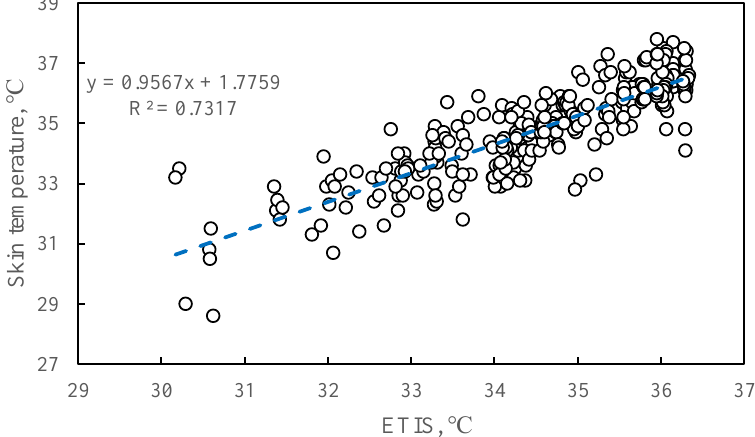
Figure 6. Regression of equivalent temperature index for sows to skin temperature based on test data. The dots represent the scatter plot of the skin temperature of the sow corresponding to the ETIS. The dotted line represents the model estimate based on the linear regression of sow skin temperature with 309 ETIS testing data. The linear regression equation here is: y = 0.9567x + 1.7759 (where y stands for skin temperature (°C) and x stands for ETIS (°C)) (R 2 = 0.7317, p < 0.0001).